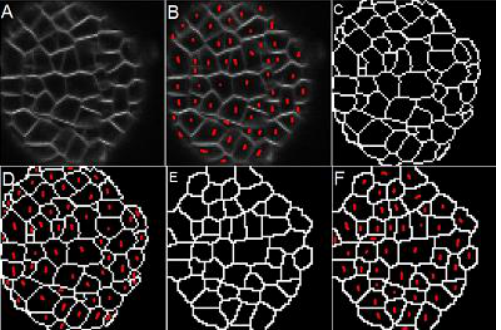
Figure 10. Cells found with the proposed method in a sub-image of Figure 1. ( A ) Sub-image. ( B ) Cells identified by hand. ( C ) Ground-truth image. ( D ) Ground-truth overlapping the original image. ( E , F ) Results obtained with the proposed technique.